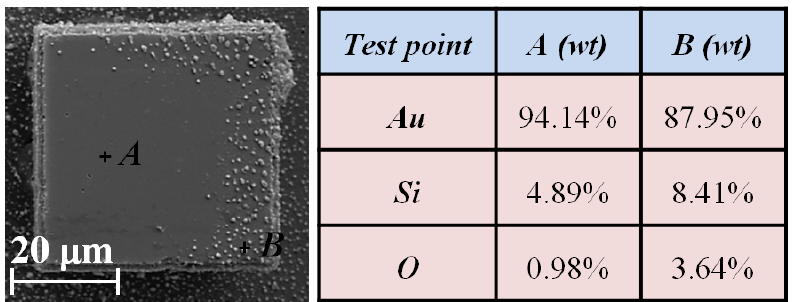
Figure 13. Energy dispersive X-ray test for Ti/Pt/Au mould after TEM.